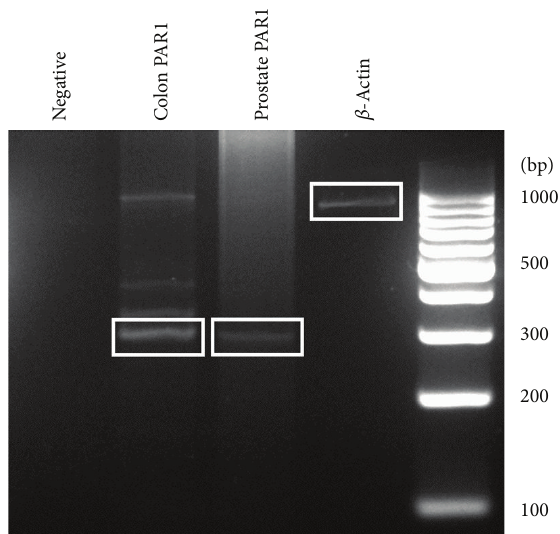
Figure 3: PAR1 mRNAis expressed in thewild-type mouseprostate. Prostates were treated with sterile saline and sacrificed 2 days posttreatment. Primers specific for mouse PAR1 were used to amplify cDNA that was reverse transcribed from homogenized mouse prostate tissue. RT-PCR lanes from left to right are as follows: primers without cDNA (negative), PAR1 colon cDNA (colon PAR1), PAR1 prostate cDNA (prostate PAR1), and 𝛽 -actin ( 𝛽 -actin). A 100bp DNA ladder was